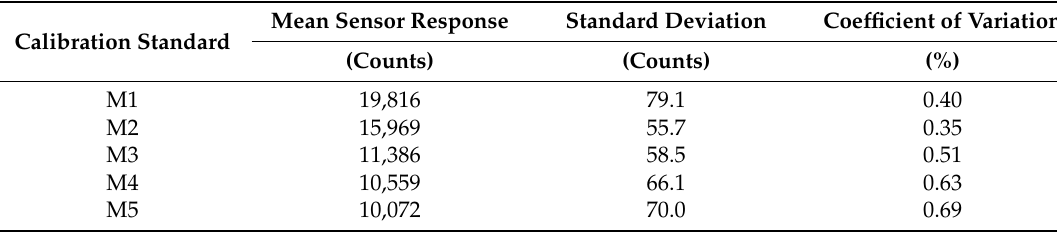
Table 3. Statistical results of the sensor response measurements using 701 SMT100